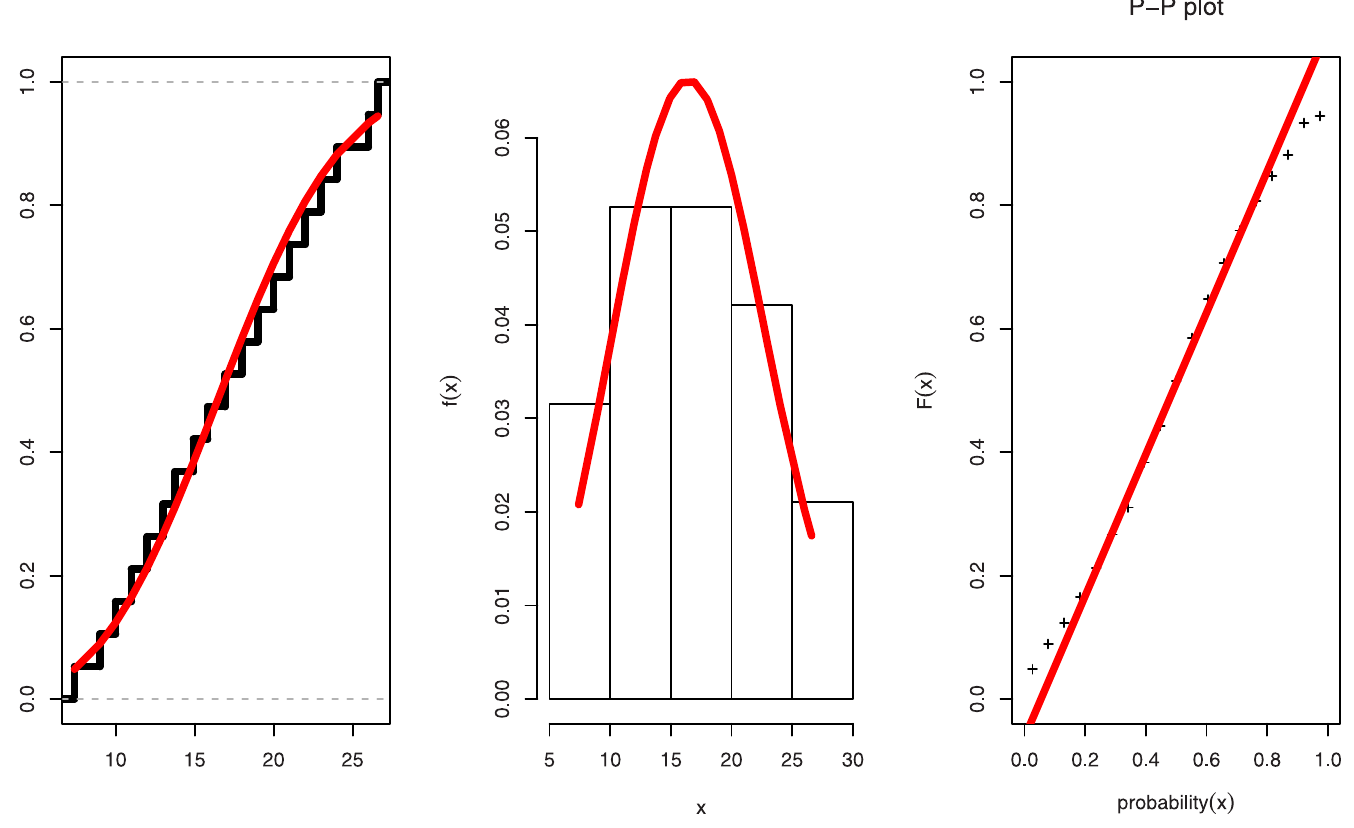
Fig 8. Estimated cdf, pdf and pp-plot for duration of diabetes